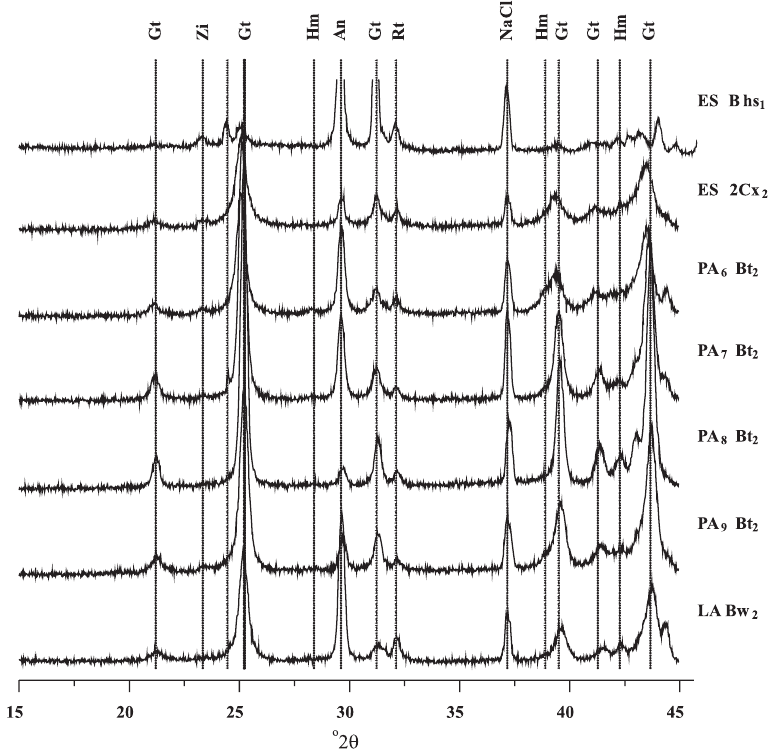
Figura 3. Difratogramas de raios X de concentrado de óxidos de ferro dos horizontes B e fragipã de alguns solos estudados. Gt: goethita, Hm: hematita; An: anatásio; Rt: rutilo; Qz: quartzo; Zi: zircão; NaCl: padrão